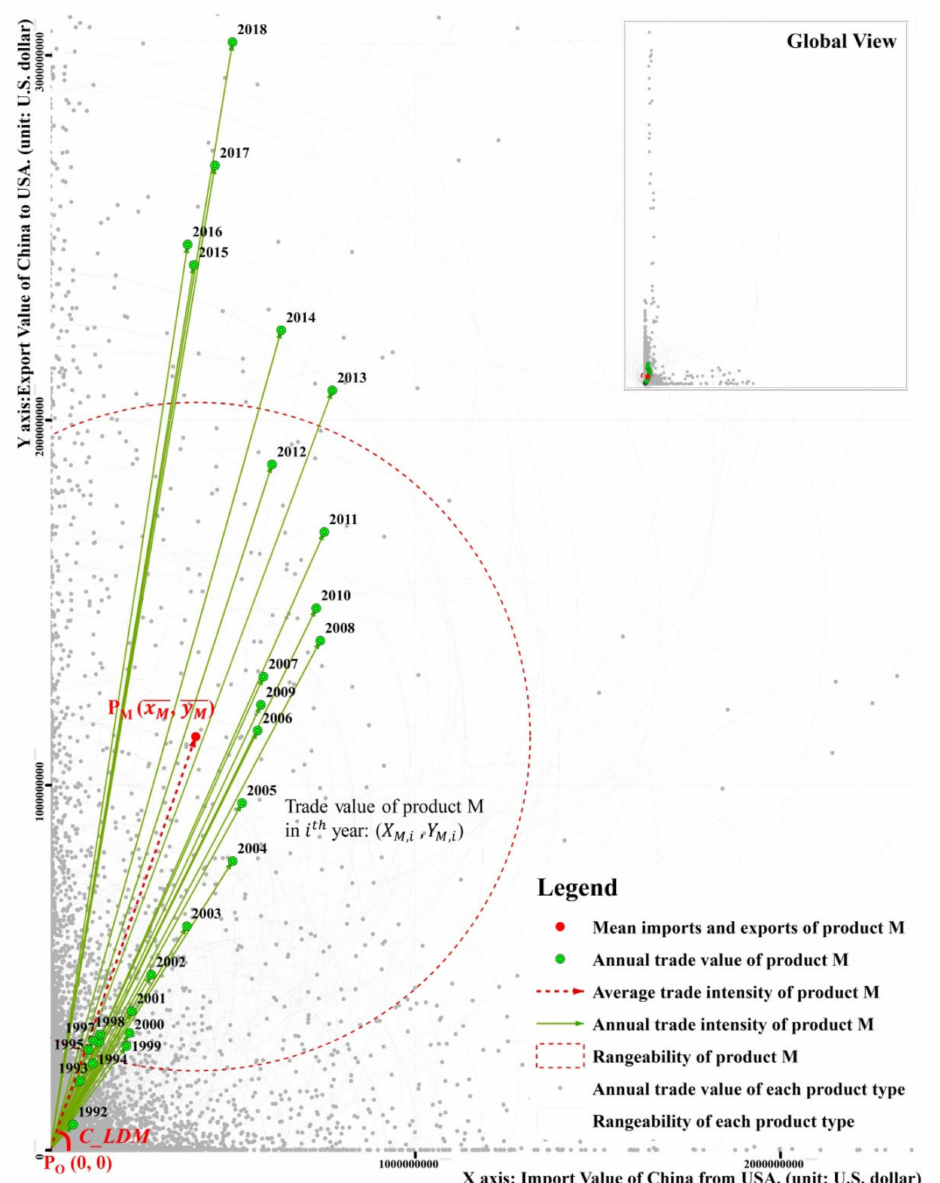
Figure 1. Variation in China–US bilateral trade in ‘trade space’. product M represents ‘Gas compressor and fan’, and its HS 4-digit code is 8414. By creating a line L that connects original point PO (0, 0) and central point P M ( x M , y ), the length of L indicates the average trade intensity of product M . M The Angle C_LDM between the L - and X -axis indicates the import–export di ff